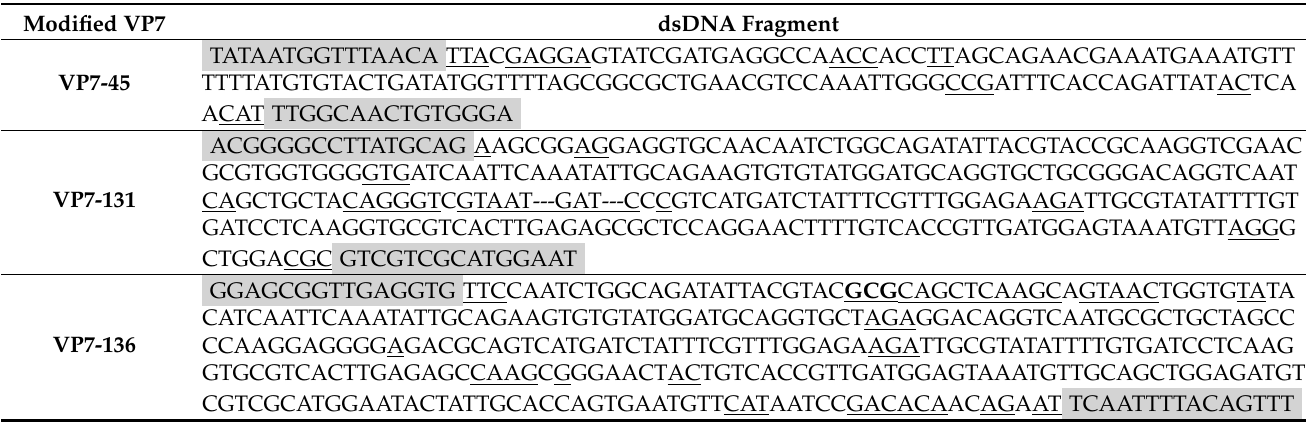
Table 1. Sequences of dsDNA fragments depicting mutations (underlined), insertions (bold), deletions (---), and 15 bp homologous flanking sequences (grey